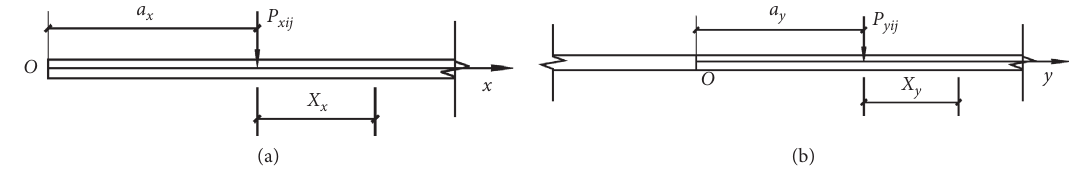
Figure 4: Elastic foundation beam model. (a) Column. (b)